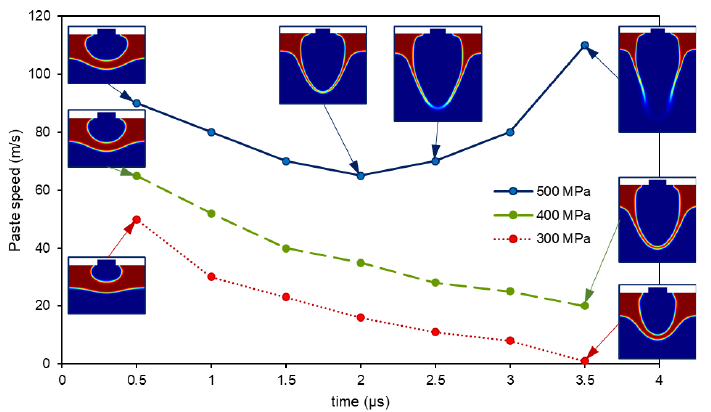
Figure 11. Paste speed versus time for a 60 µ m paste layer and an initial pressure of 300 MPa (dotted red line), 400 MPa (dashed green line), and 500 MPa (solid blue line). The burst of the paste can be seen for the last case, in which the speed raises after slowing down.